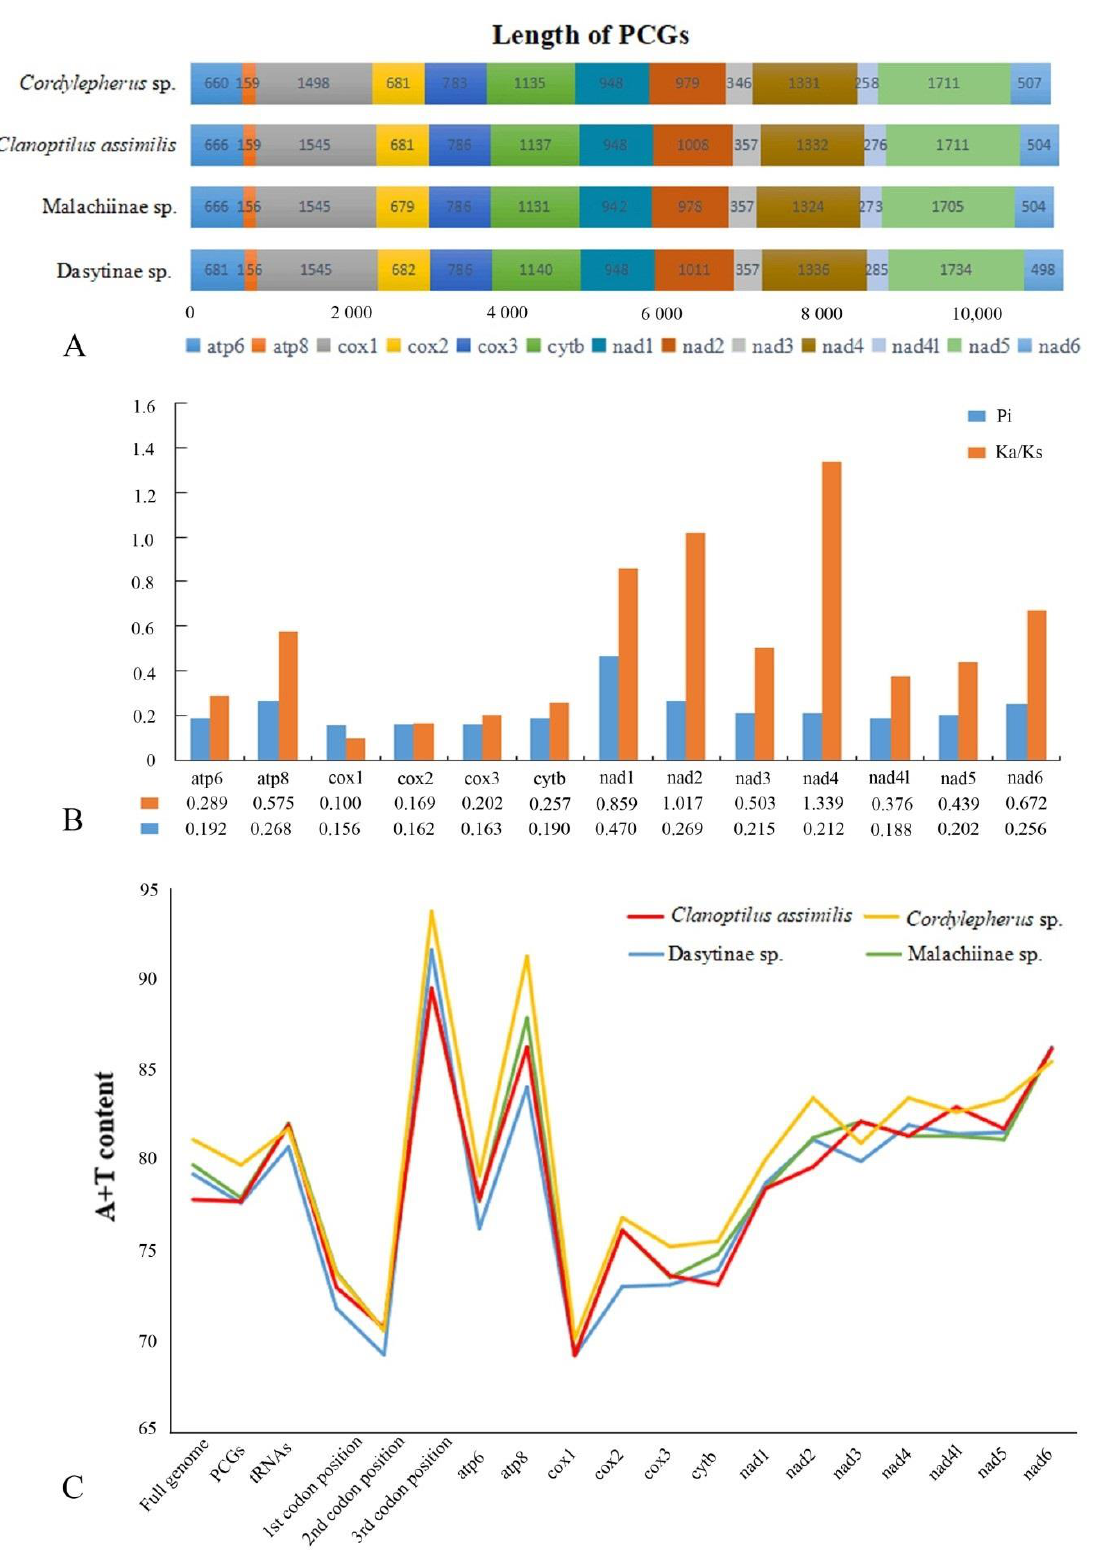
Figure 3. ( A ) Comparison of 13 PCGs in lengths of Melyridae species; ( B ) nucleotide diversity (Pi) and nonsynonymous (Ka) to synonymous (Ks) substitution rate ratios of 13 PCGs of Melyridae species (the Pi and Ka/Ks values of each PCGs shown under the gene name); ( C ) comparison of AT contents in different regions of mitogenomes of Melyridae species.